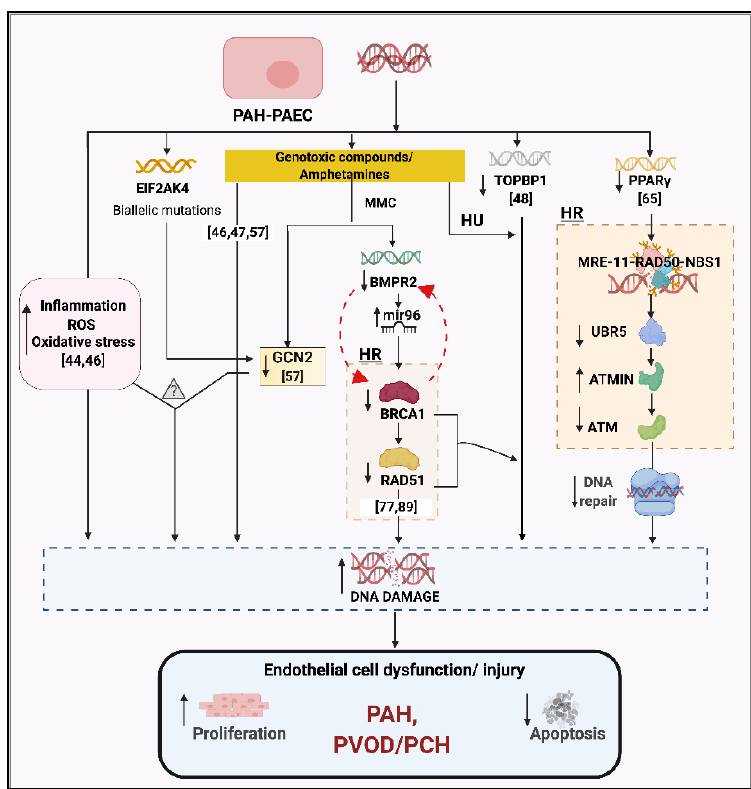
Figure 2. Dysregulated DNA damage response genes involved in pro-proliferative and apoptosis resistance characteristics of PAH-PAECs. Increased inflammation, ROS, oxidative stress, and susceptibility to genotoxic compounds are associated with increased DNA damage in PAH-PAECs. Reduced expression of PPAR γ and BMPR2 in PAH-PAECs downregulates the downstream HR DNA repair genes, ATM and RAD51, respectively. The BMPR2-BRCA1-RAD51 pathway is also dysregulated in presence of MMC, a genotoxin. MMC is also proposed to trigger pulmonary vascular dysfunction associated with DNA damage signaling via reduced GCN2 expression, leading to PVOD. A similar mechanism may contribute to familial PVOD / PCH, where GCN2 is inactivated by biallelic EIF2AK4 mutations. Similarly, reduced expression of TOPBP1, a DNA repair gene, in PAH-PAECs is reported to associate with PAH pathogenesis. These factors cause increased DNA damage, leading to endothelial cell dysfunction / injury in PAH and PVOD / PCH. The question mark symbol represents that the exact mechanism of this pathway in inducing the disease is still uncertain. DNA, Deoxyribonucleic acid; ROS, Reactive oxygen species; EIF2AK4, Eukaryotic translation initiation factor 2 α kinase 4; GCN2, eIF-2 α kinase GCN2; MMC, Mitomycin-C; BMPR2, bone morphogenetic protein receptor type 2; miR96, microRNA-96; HR, Homologous recombination; BRCA1, Breast and ovarian cancer susceptibility protein 1; RAD51, RAD51 recombinase; HU, Hydroxyurea; TopBP1, DNA Topoisomerase II Binding Protein 1; PPAR γ , Peroxisome proliferator-activated receptor γ ; MRE11, Double-strand break repair protein MRE11; RAD50, RAD50 double-strand break repair protein; NBS1, Nibrin; UBR5, Ubiquitin protein ligase e3 component n-recognin 5; ATMIN, ATM interacting protein; ATM, Ataxia telangiectasia mutated; PAH, Pulmonary arterial hypertension; PVOD, Pulmonary veno-occlusive disease; PCH, Pulmonary capillary hemangiomatosis. The numbers represented in square brackets cite the reference for that study. Created with BioRender.com.